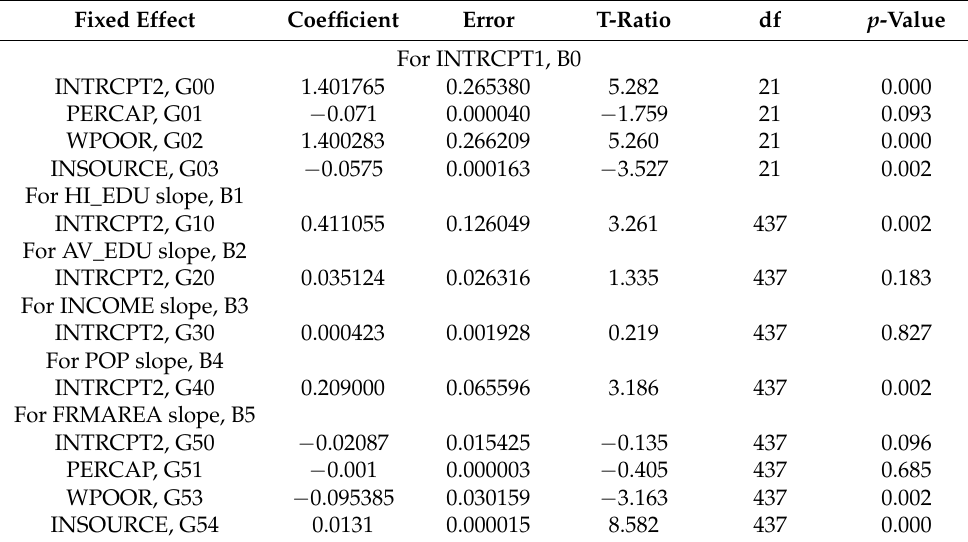
Table 6. Final estimation of fixed